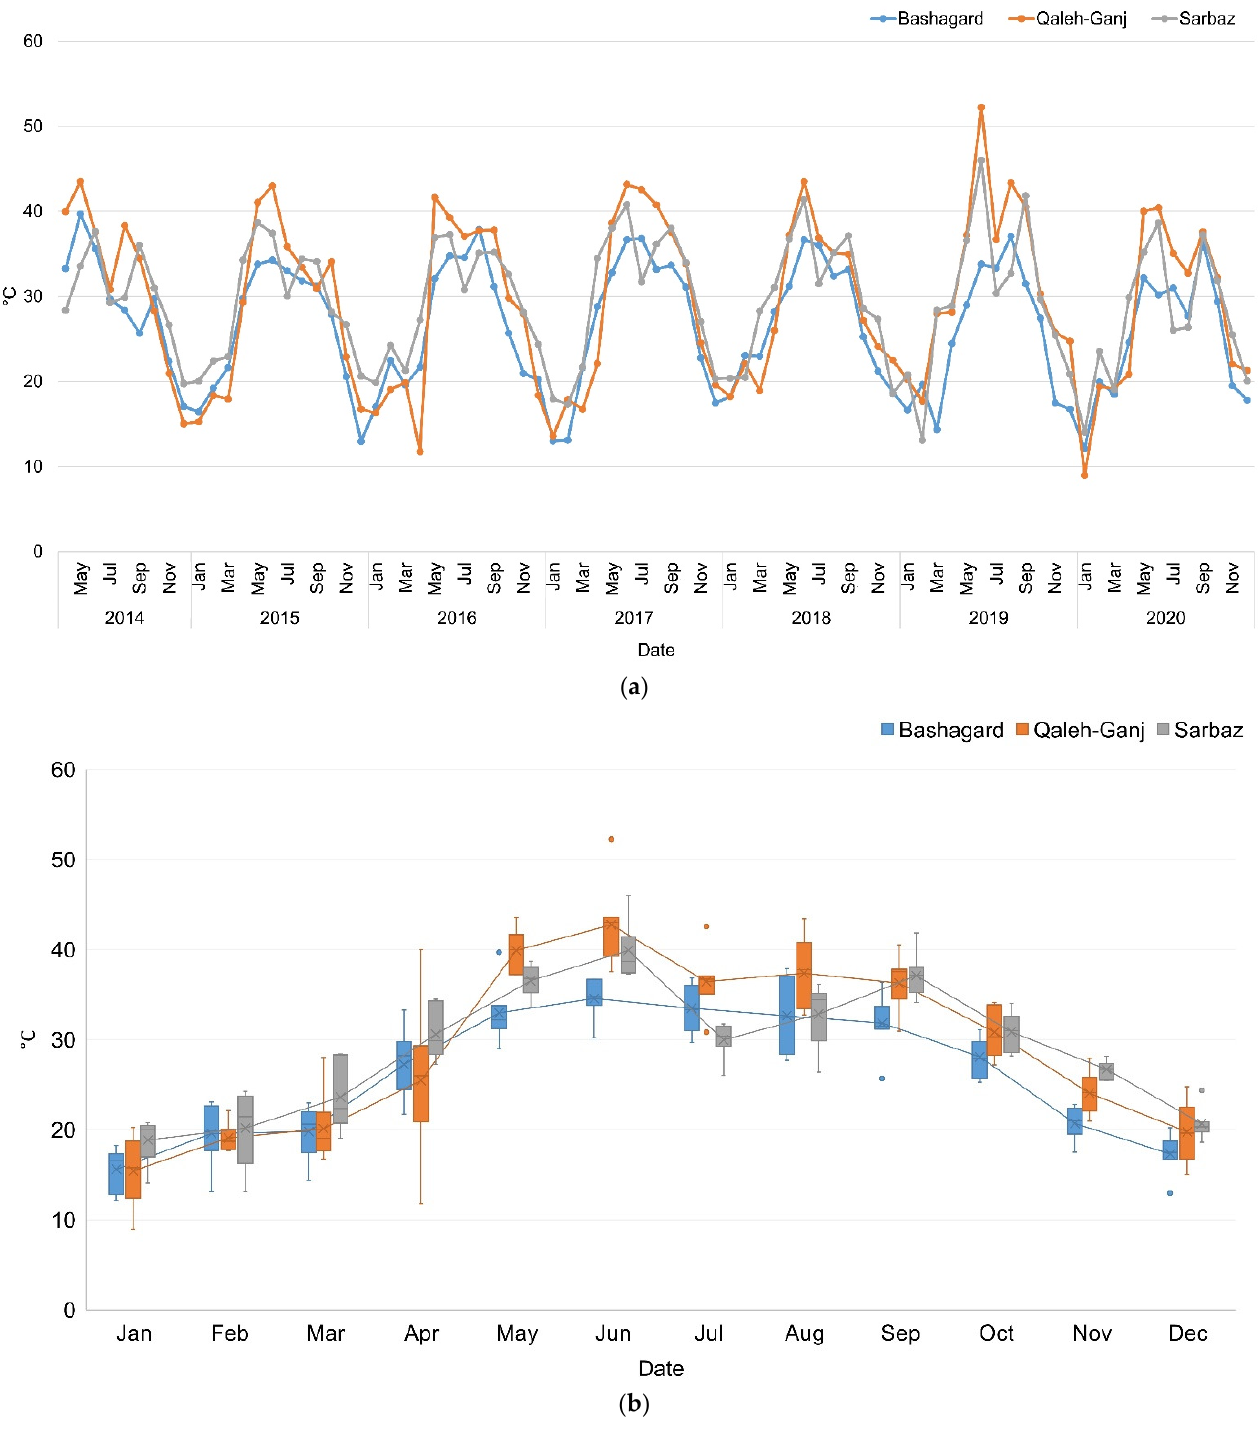
Figure 4. ( a ) Adaptive LST time series; ( b ) Box plot of adaptive LST time series of Qaleh-Ganj, Sarbaz and Bashagard counties, Iran, 2014–2020.